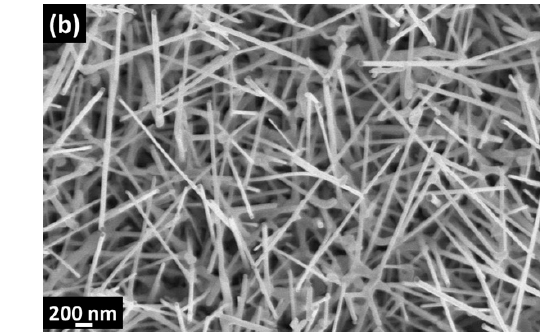
Figure 2. ( a ) 10kand ( b ) 50k × Magnified SEM images of SnO 2 nanowires.